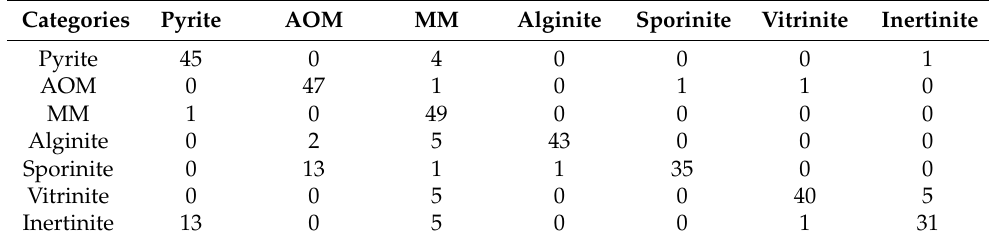
Table 1. Confusion matrix for classification result.